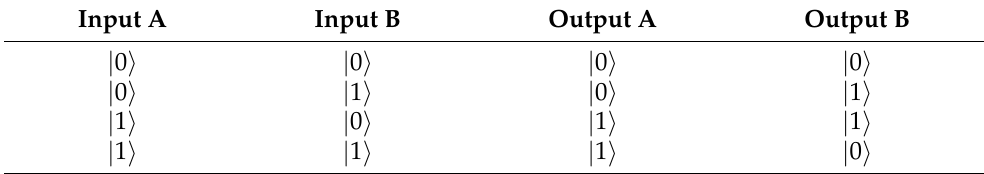
Table 3. Truth table of the CN operation.